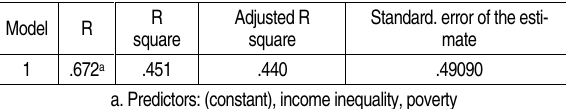
Table 10. R-square of multiple linear